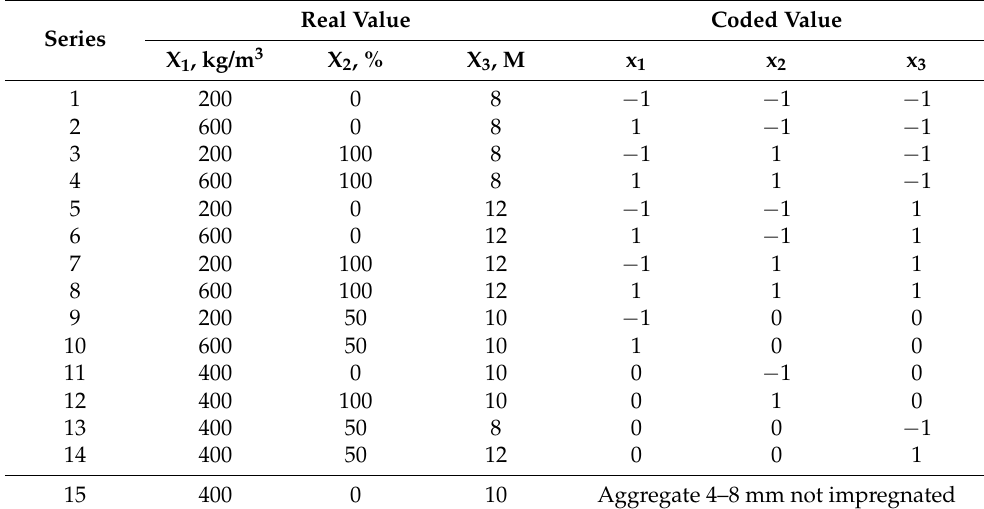
Table 6. The design of the experiment with real and coded variables.